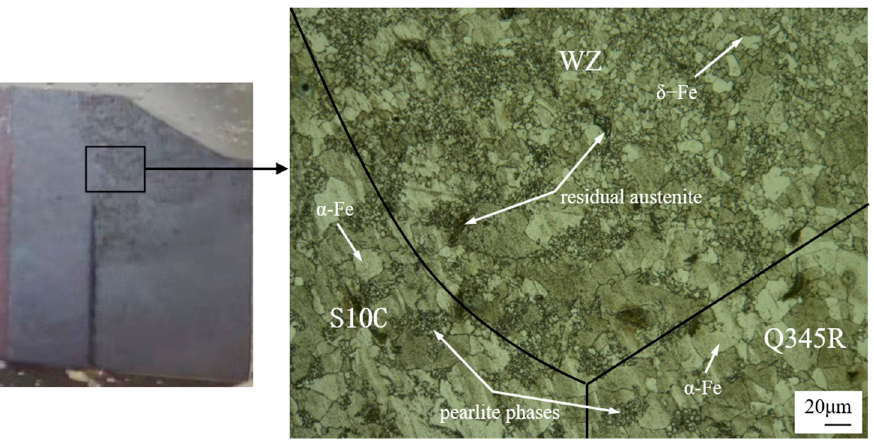
Figure 7. Digital camera photo and optical micrographs of weld zone (WZ) and base pipe for sample #1.